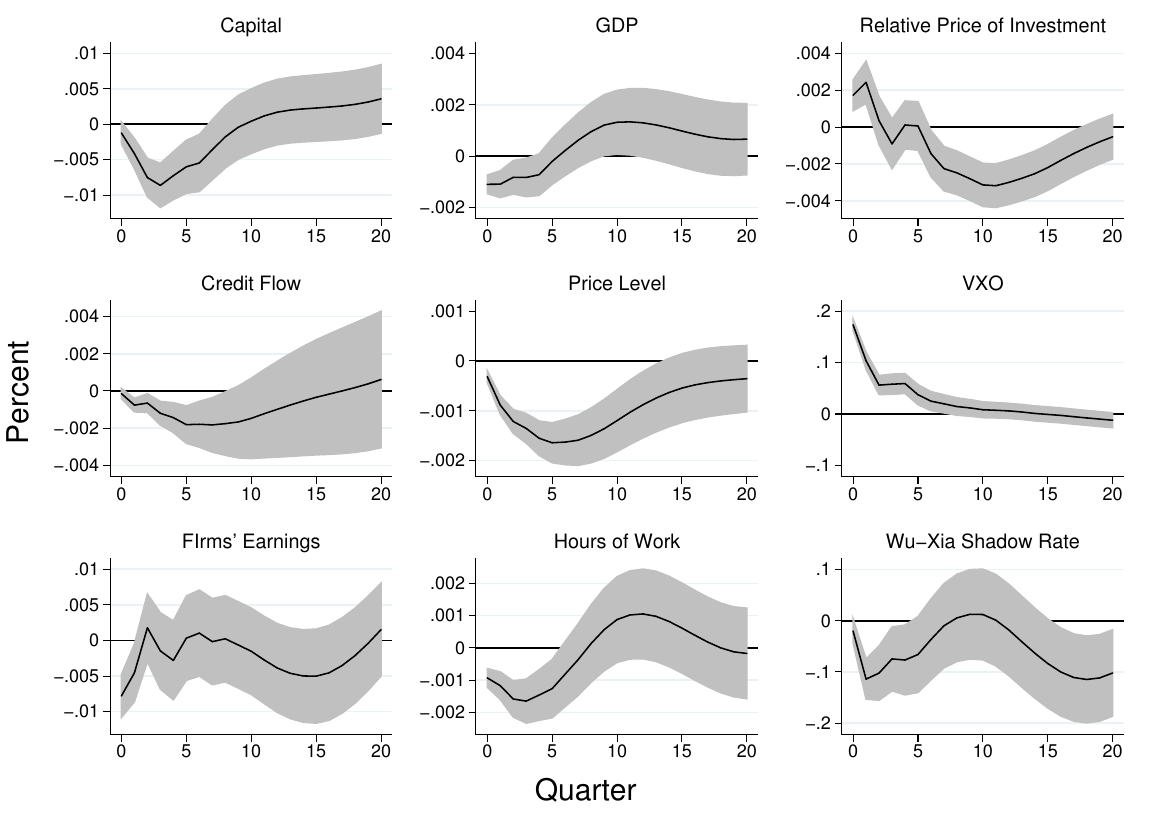
Figure A6. Uncertainty Shock Effects on the US Economy when Wu-Xia Shadow Rate is Used as a Proxy of Monetary Policy. Notes : Figure A6 shows the effect of one standard deviation increase in the VXO on the US output, Hours, Credit Flow to Non-financial Corporates, Firms’ Capital Stock, Firms’ Earning, and the Relative Price of Investment. In the impulse response functions, the shades represent the 90% confidence interval while the middle bold line represents the median response of variables due to uncertainty increase. The data are quarterly and span the period 1986Q1-2019Q4. In the VAR model, all the variables are in log levels, with the exception of the federal funds